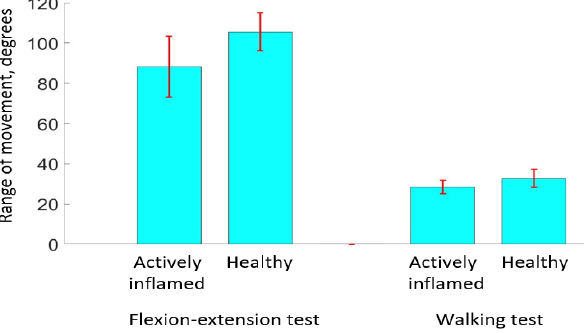
Figure 5. Mean ROM for flexion ‐ extension and walking tests. The red lines on the top of the bars are indicators of associated standard deviations.